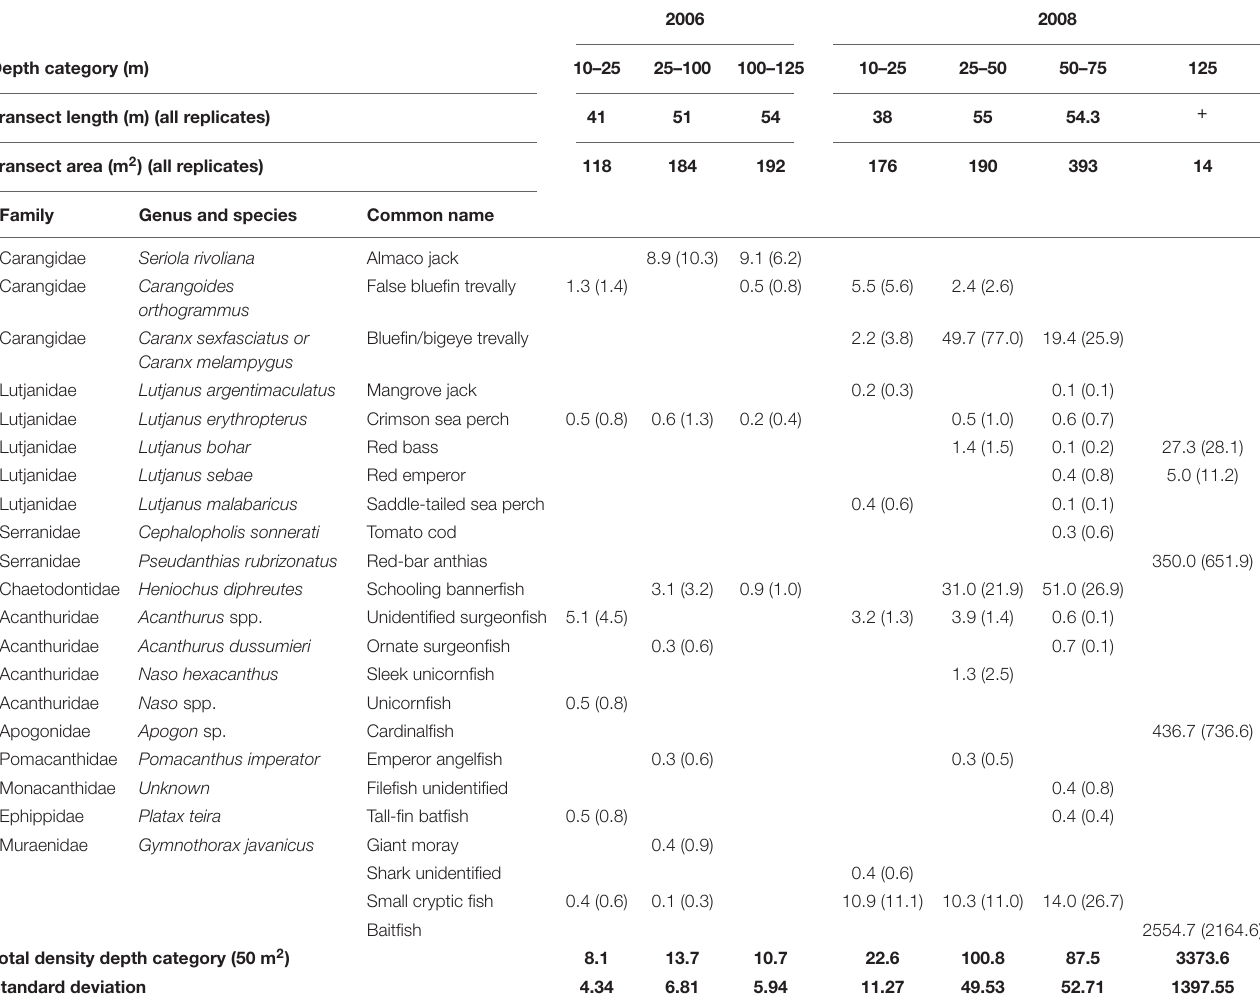
TABLE 4 | Fish taxa and mean densities (fish/50 m 2 ) identified over three to four depth categories between 10 and 125 m on Goodwyn Alpha platform in 2006 and